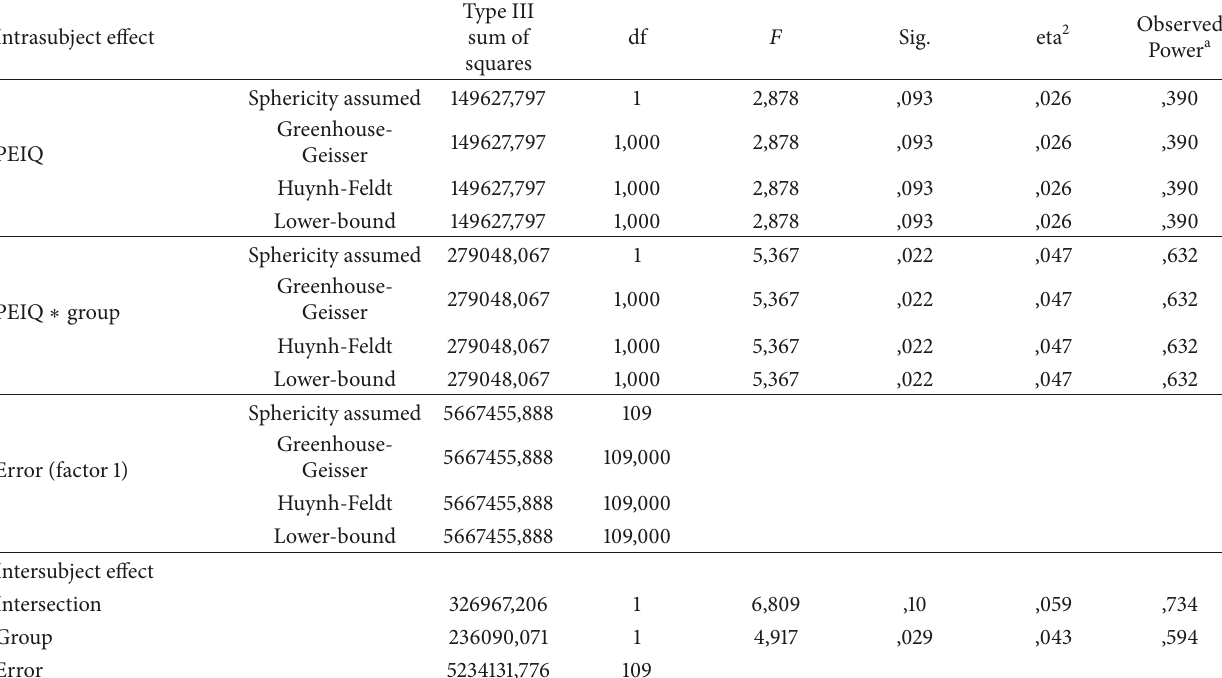
Table 4: PEIQ intrasubject and intersubject effects.